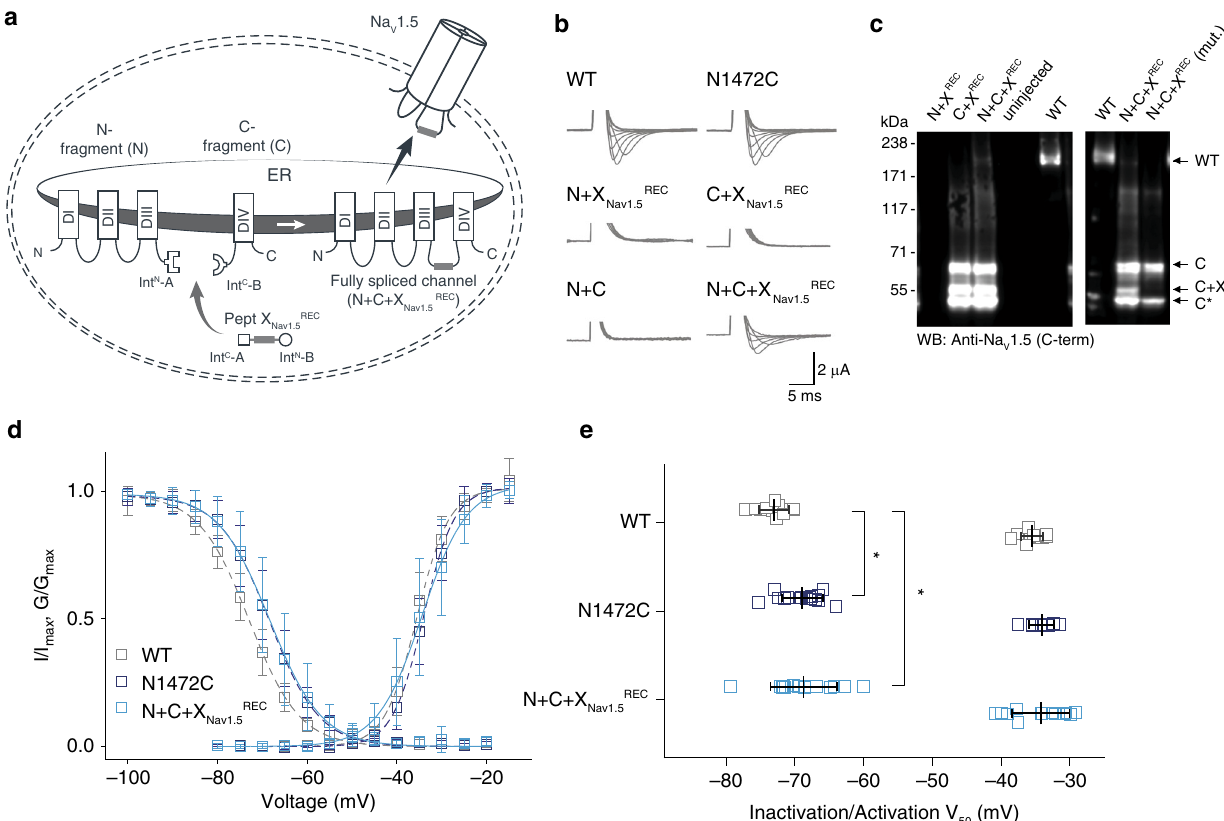
Fig. 2 Insertion of recombinantly expressed peptides into the DIII – IV linker of NaV1.5. a Schematic presentation of the strategy to reconstruct full-length Na V 1.5 from recombinantly expressed N-/C-terminal fragments (N and C) and a recombinantly expressed peptide corresponding to amino acids 1472 to 1502 of the Na V 1.5 DIII – DIV linker (X) in Xenopus laevis oocytes. Inteins A ( Cfa DnaE) and B ( Ssp DnaB M86 ) are indicated by square and round symbols, respectively. Note that we cannot exclude the possibility that splicing takes place at a different subcellular location than depicted here. b Representative sodium currents in response to sodium channel activation protocol (see methods; only voltage steps from − 50 to + 10 mV in 10 mV steps are displayed), demonstrating expression of functional Na V 1.5 only in the presence of all three components (N + C + X), along with WT and N1472C channels (the latter mutation was introduced to create an optimized splice site for intein A. c Immunoblots verifying the presence of fully spliced Na V 1.5 only when all three components (N + C + X) were co-expressed (using antibody against Na V 1.5 C-terminus). Na V 1.5 band was not detected when one component was missing (left blot) or when non-splicing mutation (N + C + X mut.) was introduced to prevent splicing (right blot; see Supplementary Fig. 2). Black arrows indicate band positions of the respective constructs (Actual MW of constructs: WT, 227 kDa; C-construct, 79 kDa; C + X, 65 kDa; C-terminal cleavage product, C*, 58 kDa). Note that X and X REC refer to X Nav1.5 REC in this panel. d Steady-state inactivation and conductance – voltage (G – V) relationships for functional constructs tested. e Comparison of values for half-maximal (in)activation ( V 50 ) (values are displayed as mean + / – SD; WT, n = 12; N1472C, n = 14; N + C + X REC , n = 16). Signi fi cant differences were determined by one-way ANOVA with a Tukey post-hoc test. * p < 0.03 (WT vs. N1472C, Nav1.5 p